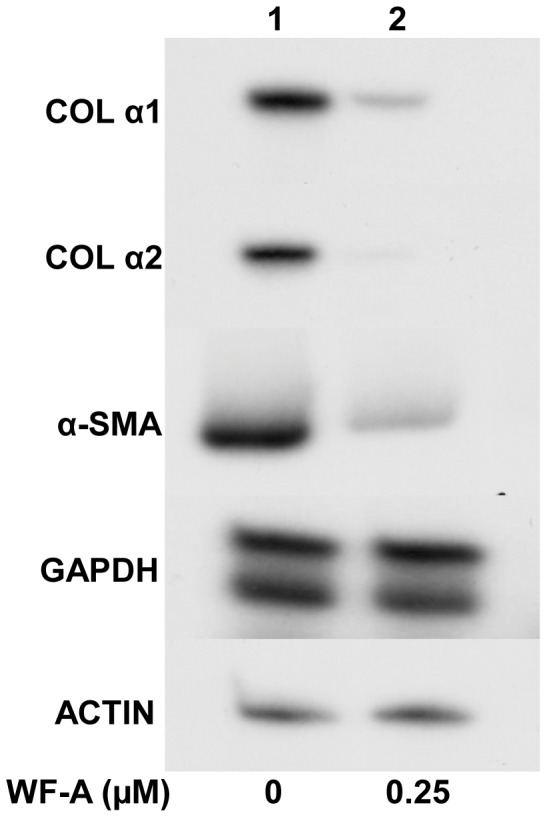
WF-A inhibits culture activation of primary rat HSC.HSC were isolated from rat livers and cultured for 2 days, when the cells were treated with DMSO (lane 1) or WF-A (0.25 µM, lane 2). At day 6, total RNA was analyzed for collagen α1(I) mRNA (COLα1), collagen α2(I) mRNA (COLα2) and α-smooth muscle actin mRNA (α-SMA) by RT-PCR. Loading controls: actin mRNA and GAPDH mRNA.